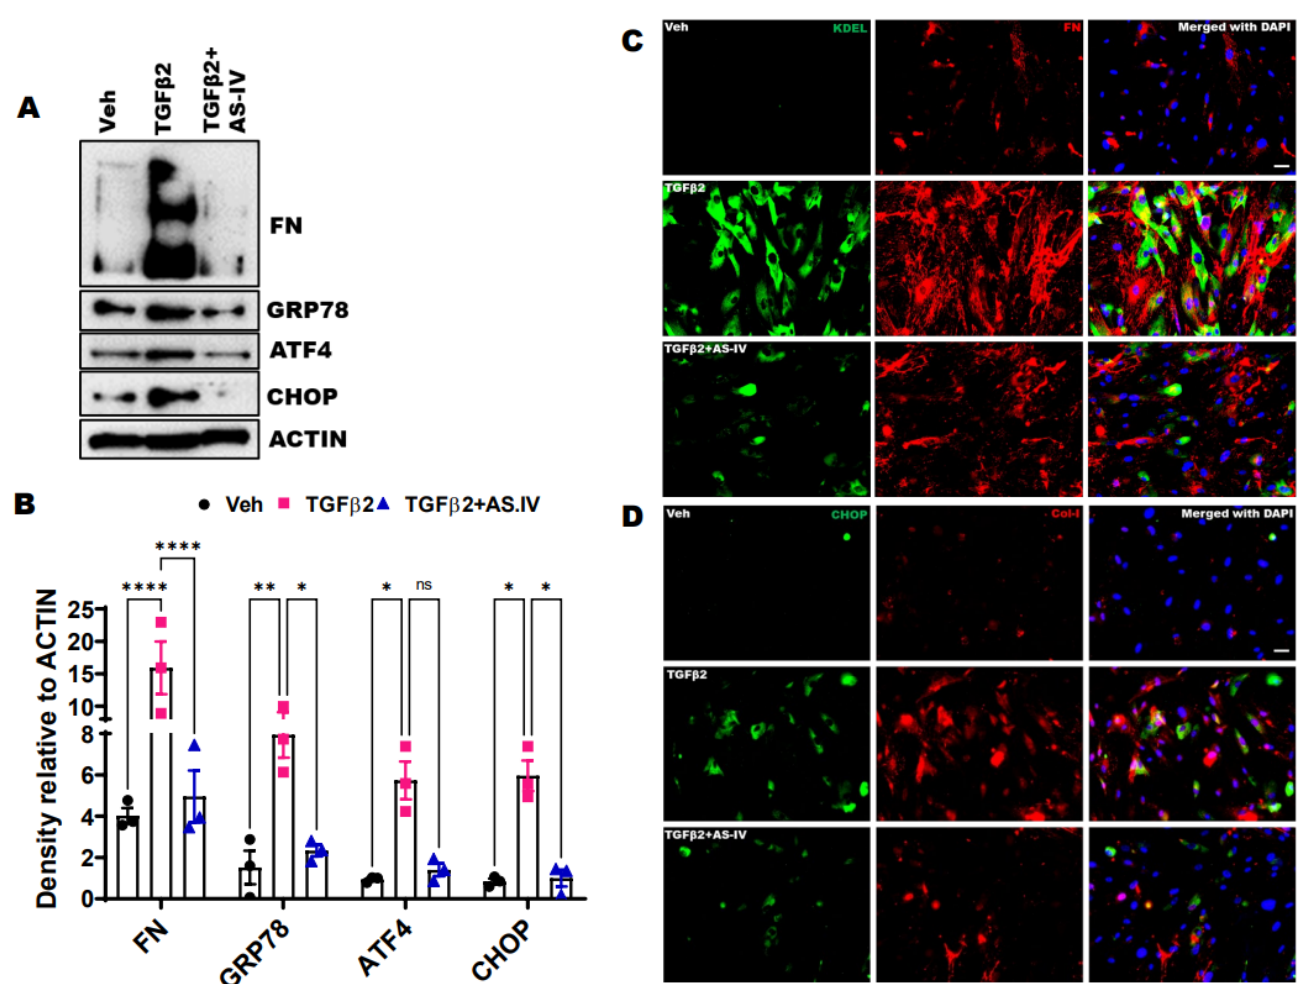
Figure 2. AS.IV treatment prevents the TGF β 2 induced ECM deposition and ER stress in TM cells. The primary human TM cells were treated with vehicle, TGF β 2 (5 ng/mL) and TGF β 2 plus AS.IV (100 µM) for 3 days. ( A , B ) The cell lysates were analyzed by Western blot ( A ) and densitometric ( B ) analysis of ECM (FN) and ER stress (GRP78, ATF4, and CHOP) markers. The AS.IV co-treatment significantly reversed the TGF β 2 induced ECM changes and ER stress. ( n = 3 cell strains, data represented as mean ± SEM, 2-way ANOVA, Tukey’s multiple comparisons test, * p < 0.05, ** p < 0.01, **** p < 0.0001). ( C , D ) represents immunostaining analysis on fixed TM cells treated with vehicle, TGF β 2 and TGF β 2 plus AS.IV. A prominent decrease in FN, Col-I (ECM), KDEL and CHOP (ER stress) staining in the AS.IV co-treated cells compared to the TGF β 2 treatment alone, indicates decreased ECM deposition and ER stress ( n = 3 cell strains, scale bar 10 µm).